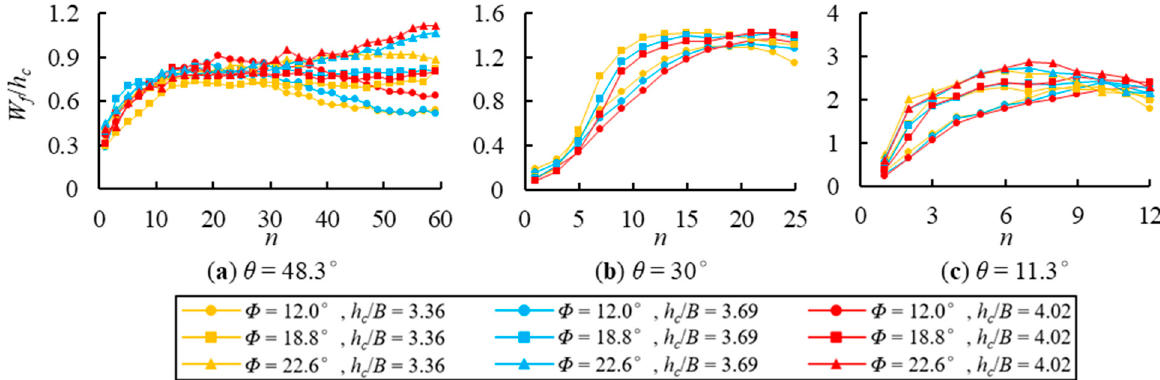
Figure 7. Dimensionless disturbed region width of W f / h c for free-surface: ( a ) θ = 48.3°; ( b ) θ = 30°; ( c ) θ = 11.3°.